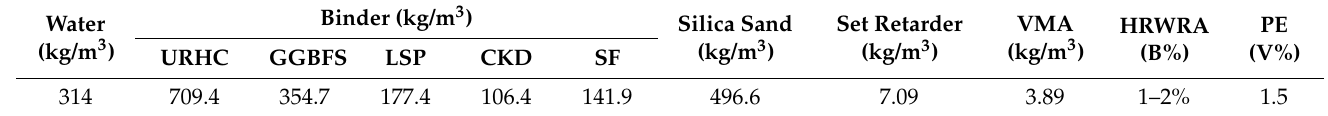
Table 1. URH-FRM mix design.